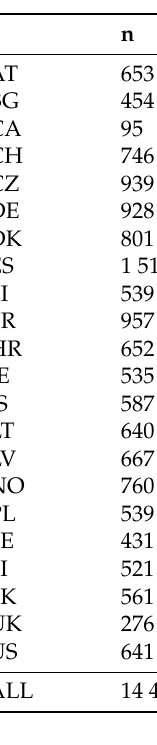
Table A1. Number of cases per country and response